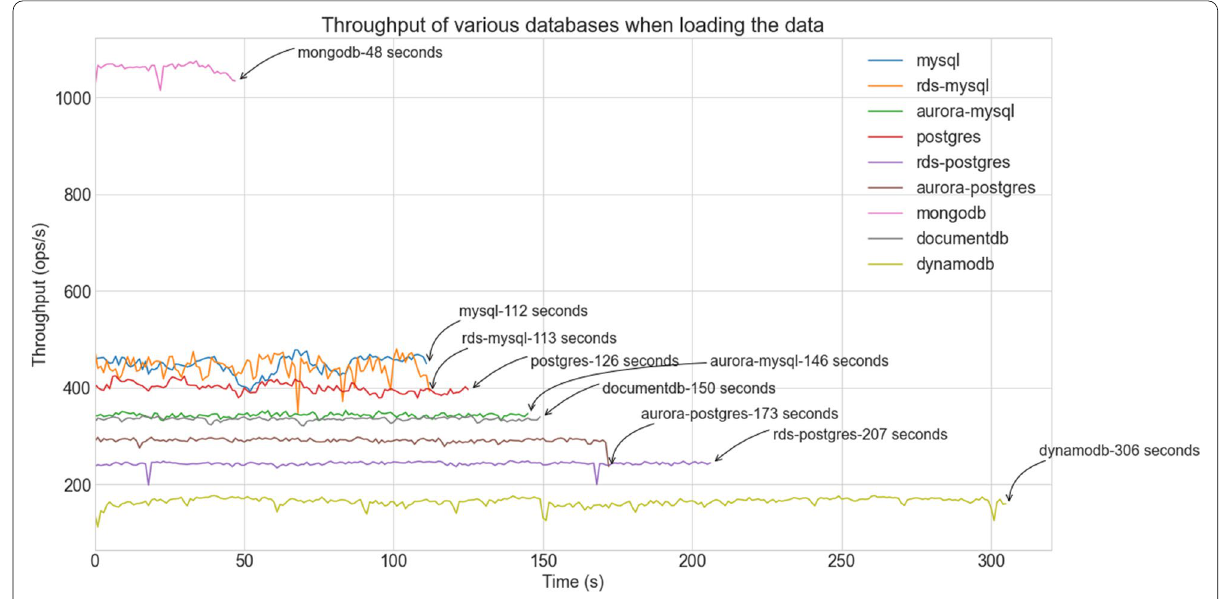
Fig. 4 Performance of databases with ‘load’